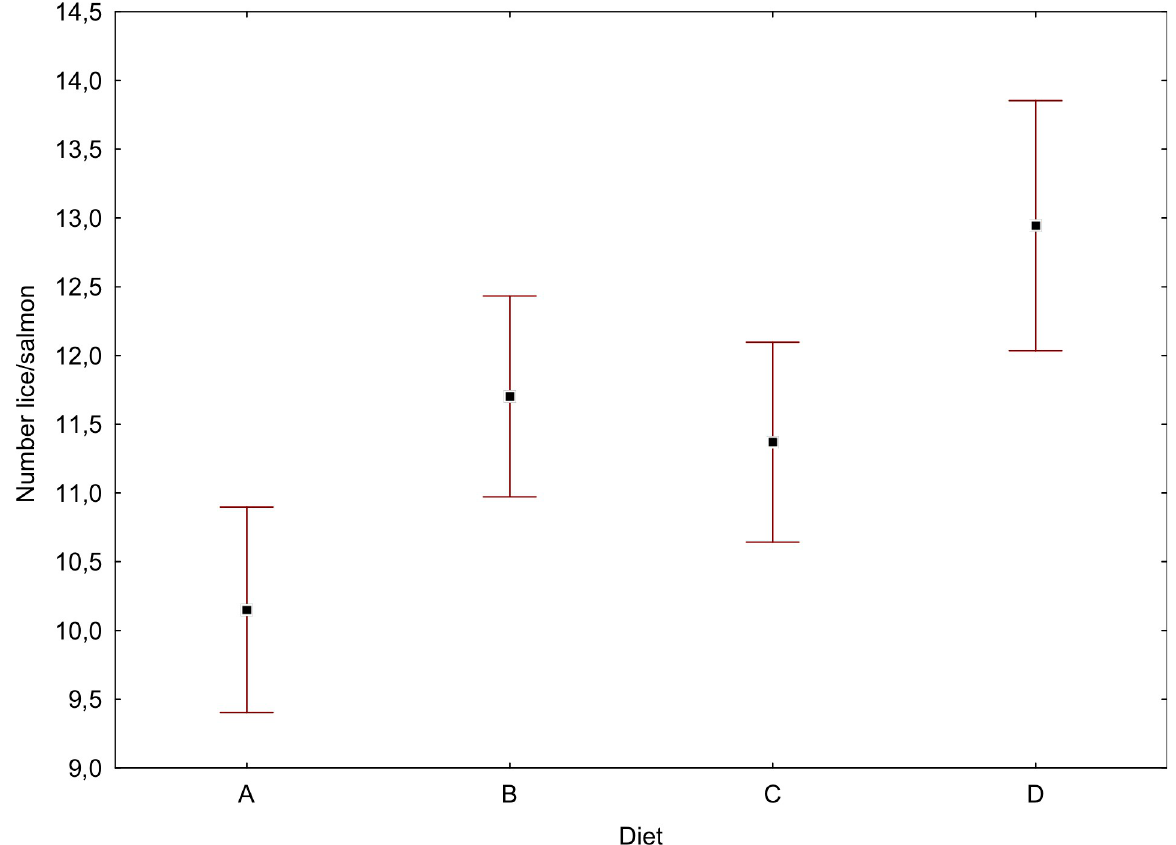
Fig 2. Number of lice per fish fed diets A–D on experiment day 82 (T3).